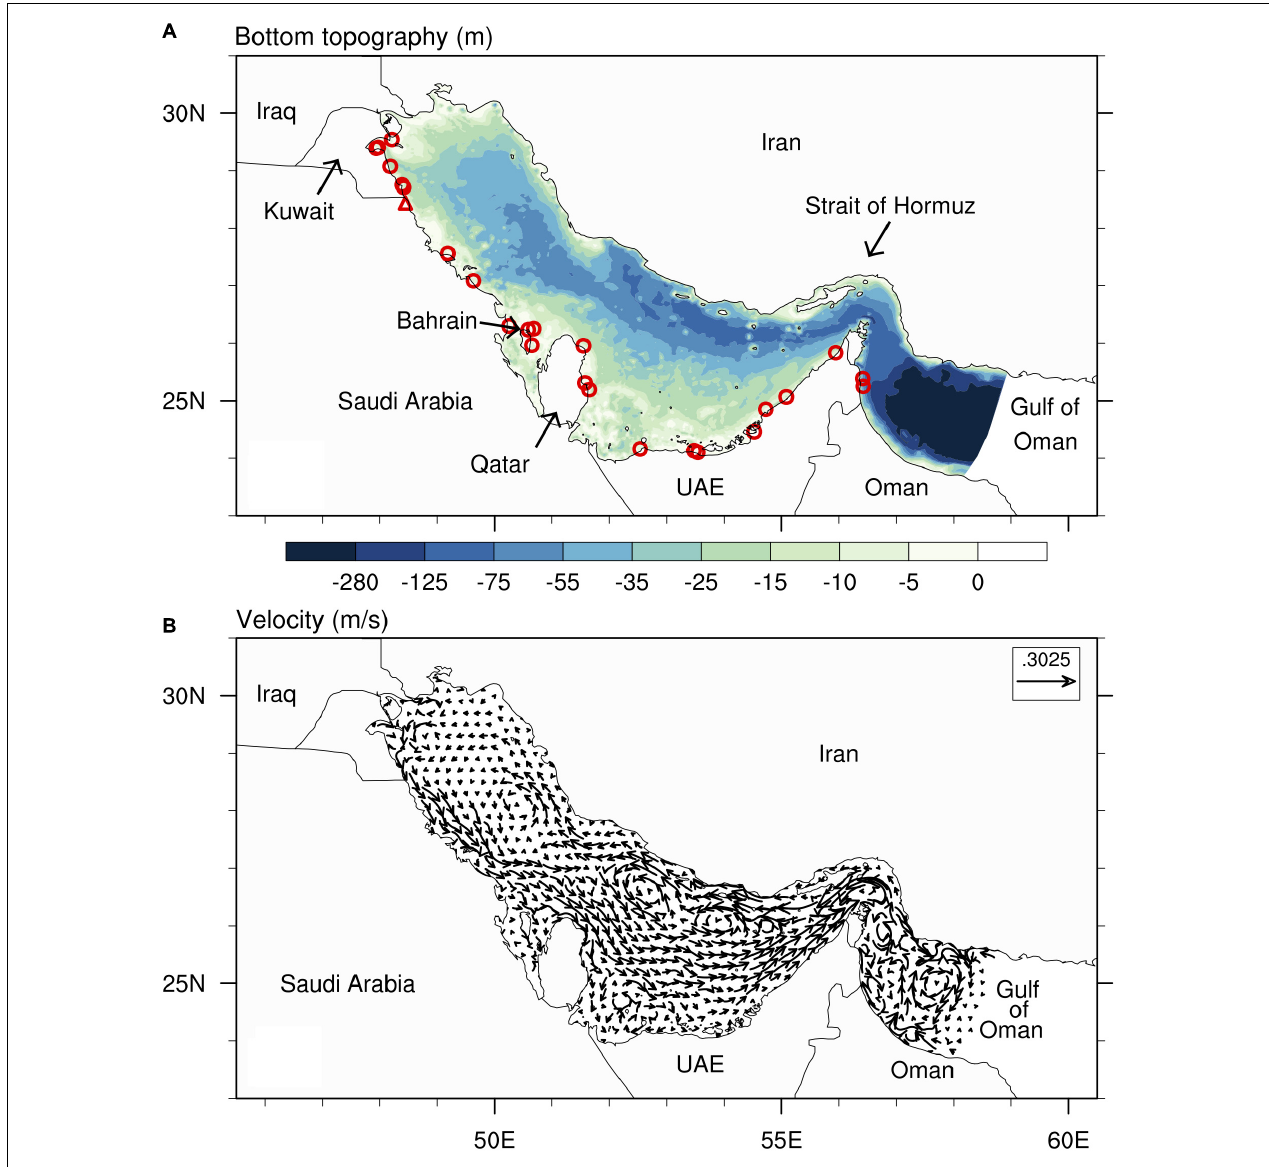
FIGURE 1 | Gulf bottom topography and residual circulation (RS) characteristics: (A) Bottom topography; mean depth is approximately 35 m, and depth decreases from east to west; triangle marker indicates position of freshwater sink in D1a experiment and circle markers indicate positions of freshwater sink in D1b and D1c experiments (see Table 1 ). (B) Depth-average RS horizontal velocity when lateral extent is maximum